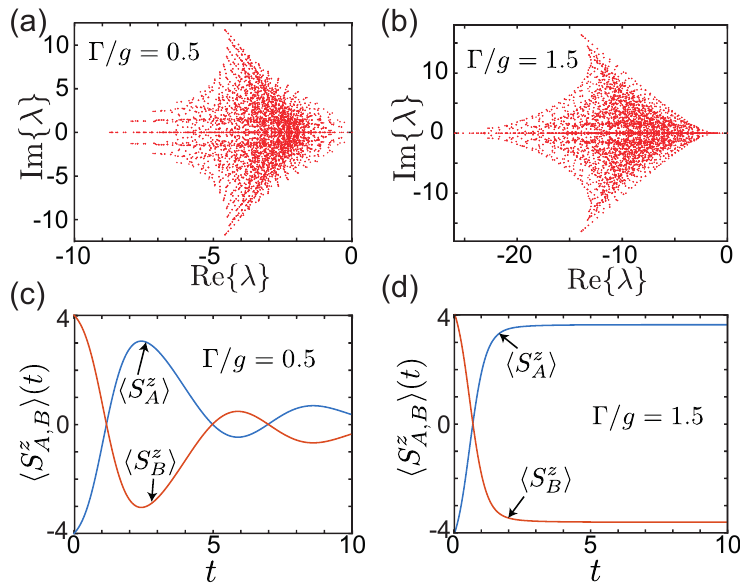
Figure 3: Plot of all complex eigenvalues λ of the Liouvillian L for the PT -symmetric i spin system introduced in Fig. 1(a) with S = 4. In (a) the spectrum is shown below ( Γ / g = 0.5) and in (b) above ( Γ / g = 1.5) the transition point. For the same parame- 〉 ( t ) , ters, (c) and (d) show the corresponding time evolution of the observables 〈 S z A , B starting from the initial state ρ ( t = 0 ) = | − S 〉〈− S | ⊗ | S 〉〈 S |